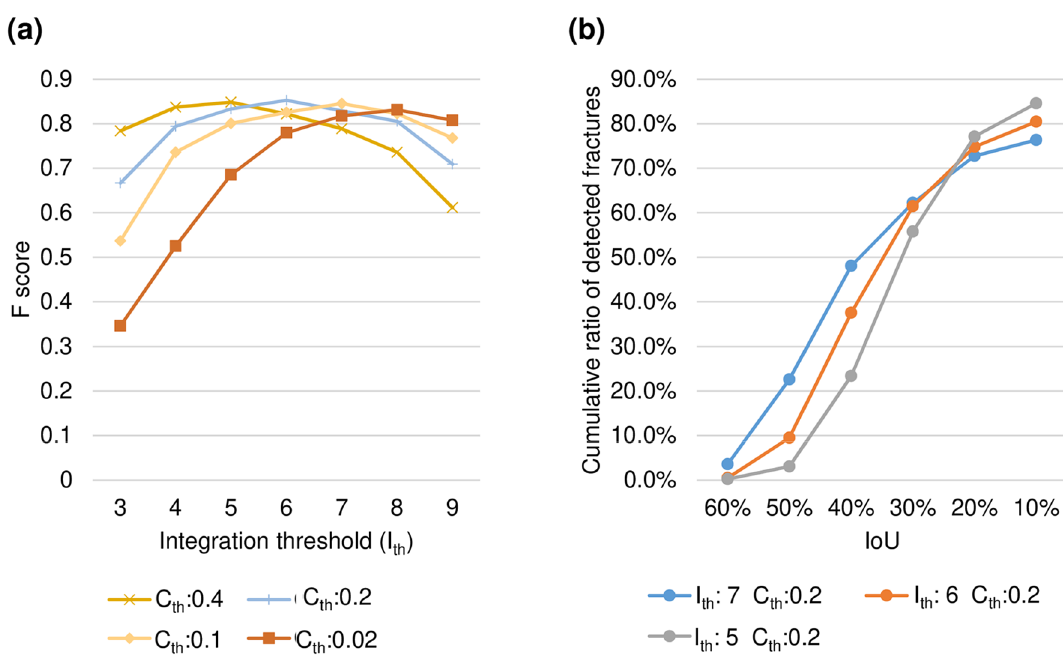
Figure 5. Performance dependency on analysis parameters. ( a ) Relationship between I th and C th . ( b ) Cumulative histogram of IoU of the detected